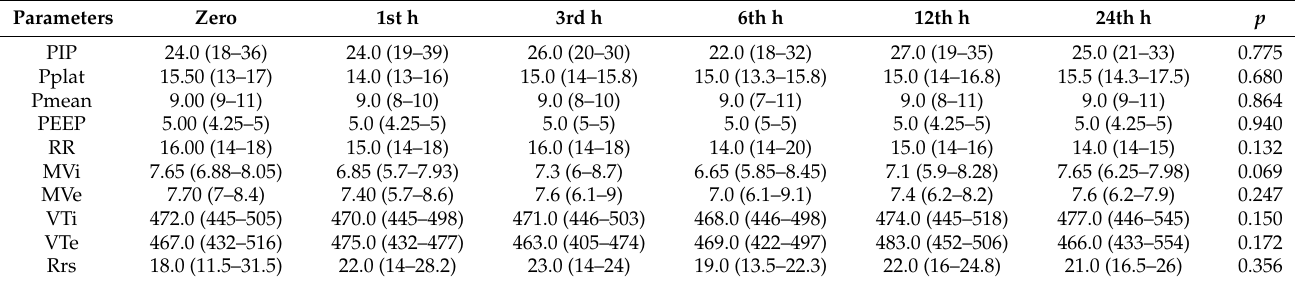
Table 2. Respiratory parameters from